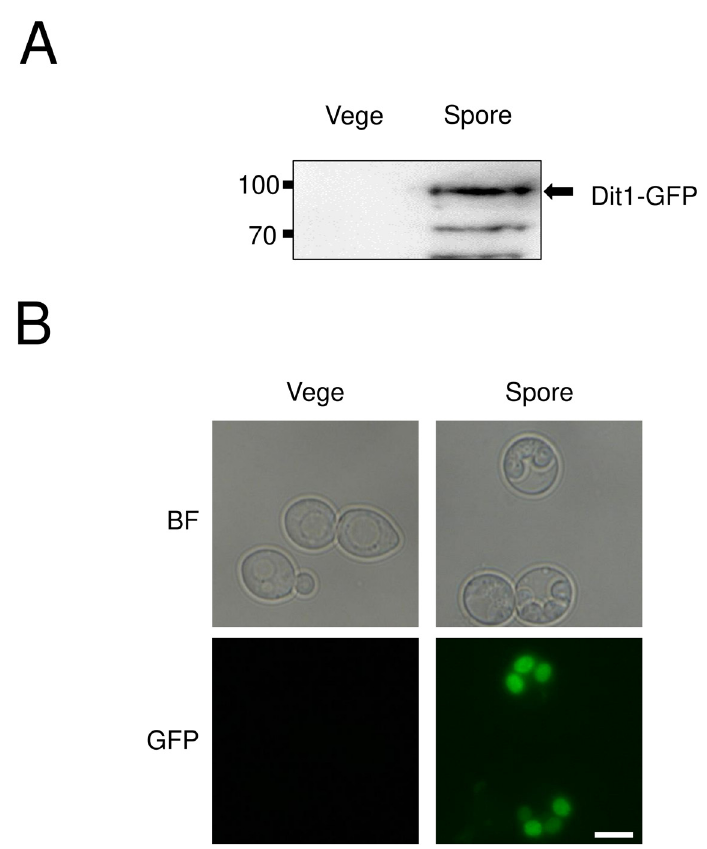
Figure 2. Analysis of Dit1 localization. A ) A diploid strain in which the chromosomal DIT1 genes were fused to GFP. Vegetative growing cells (Vege) and spores of the DIT1-GFP harboring cells were lysed and subjected to Western blotting analysis using anti-GFP antibodies. B ) Vegetative growing cells (Vege) and spores of the DIT1-GFP harboring cells were observed by bright field (BF) and florescence microscopy (GFP). Bar, 5 µm.